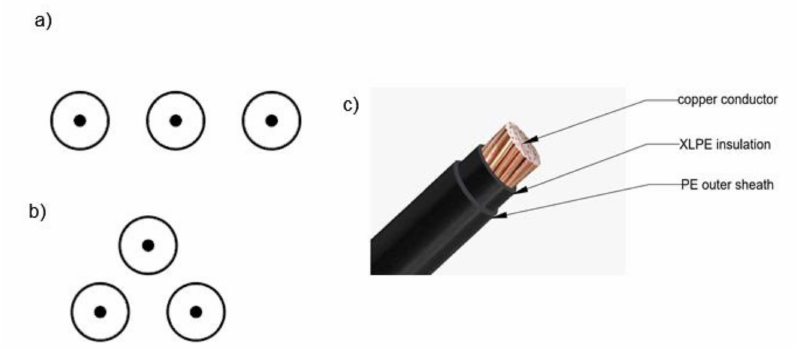
Figure 1. Cable arrangement: ( a ) flat formation, ( b ) trefoil formation, and ( c ) electrical cable